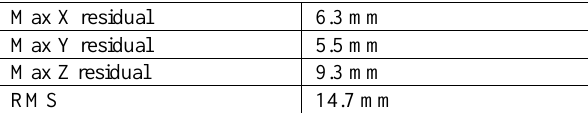
Table 3 - Results of MicMac model construction processing